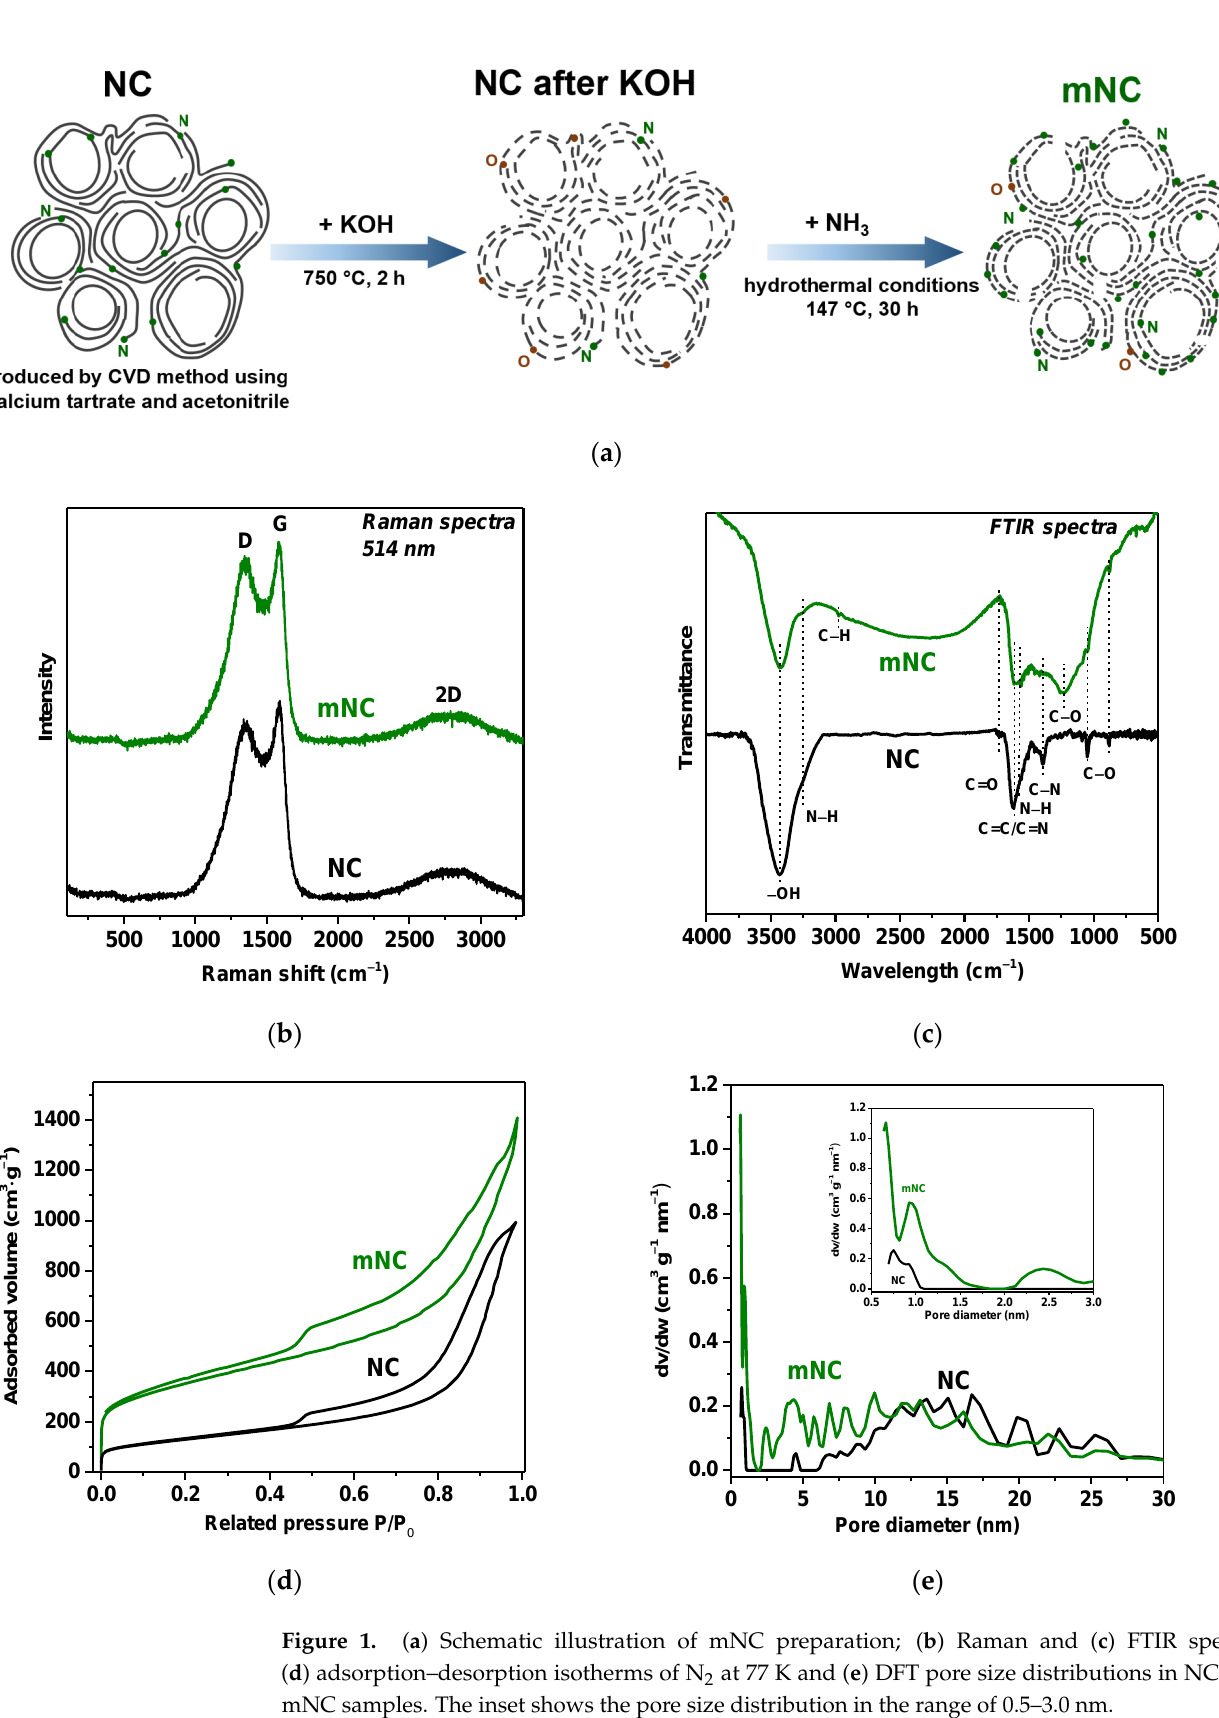
Figure 1. ( a ) Schematic illustration of mNC preparation; ( b ) Raman and ( c ) FTIR spectra, ( d ) adsorption – desorption isotherms of N 2 at 77 K and ( e ) DFT pore size distributions in NC and mNC samples. The inset shows the pore size distribution in the range of 0.5 – 3.0 nm.